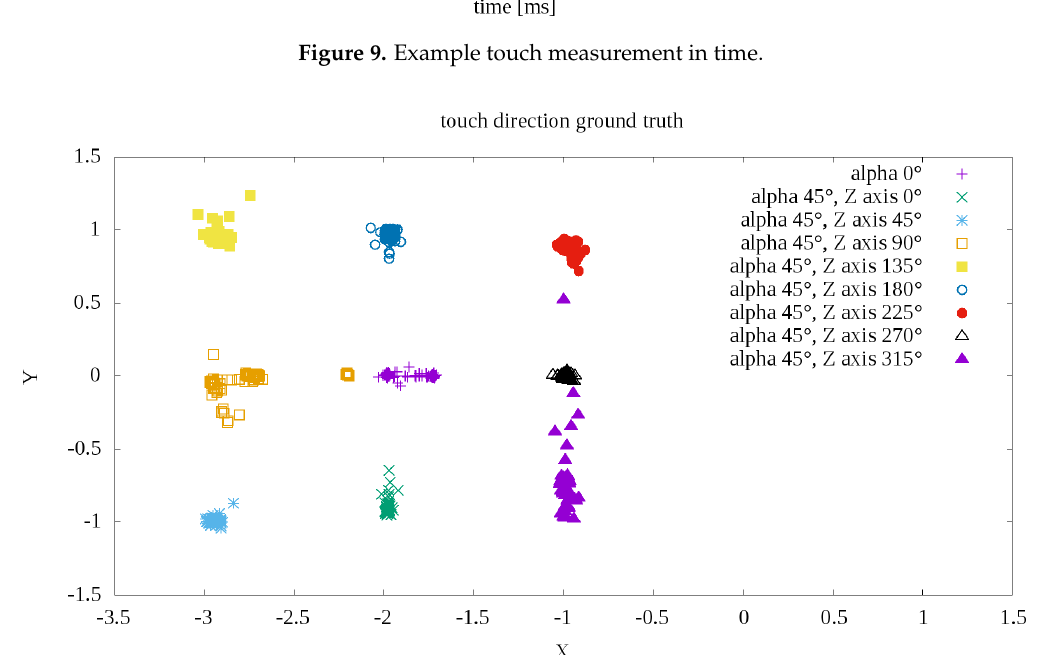
Figure 10. Example POC (Phase Only Correlation) measurements depending of touch